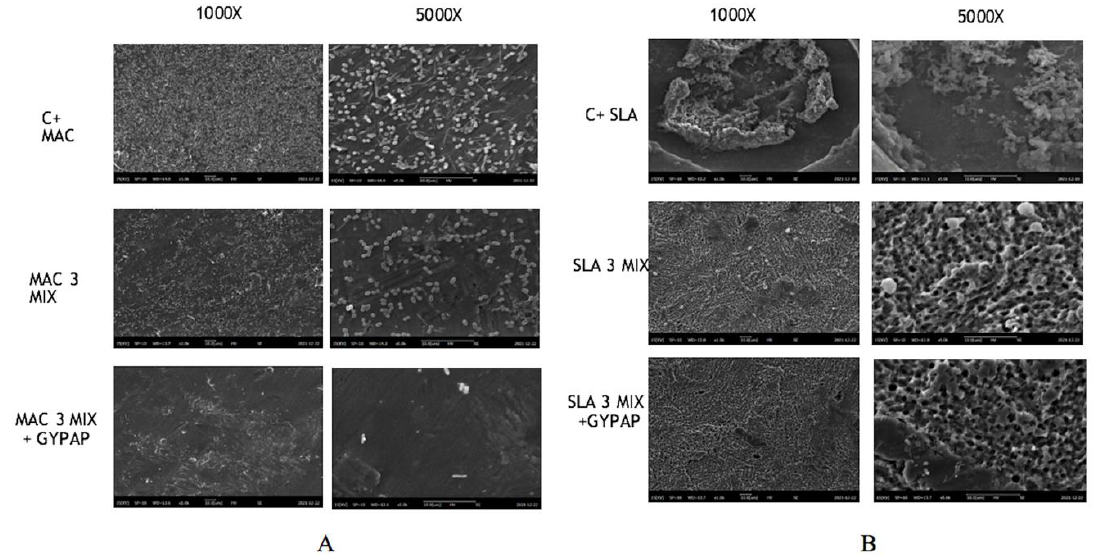
Figure 4. Scanning electron microscopy (SEM) images of the machined (MAC) and acid etched surface (SLA) titanium surfaces at magnifications of 1000 × and 5000 × with two different decontamination protocols. From left to right: ( A ) MAC, ( B ) SLA. From top to bottom: (i) positive control, (ii) after 3MIX treatment, (iii) after 3MIX + GYPAP treatment.